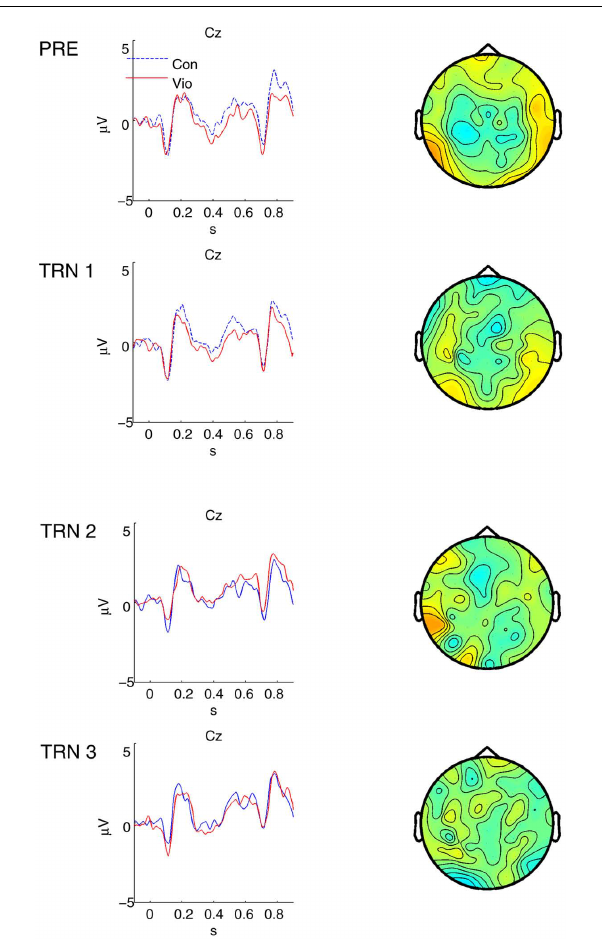
FIGURE 6 |Average event-related potentials for declension violation contrast (3 word). Trace plots indicate average voltage (in μ V) as a function of time at Cz/1; control = Con, violation = Vio.There were no statistically significant clusters.Topographical plots are viewed from the top (left is on the left-hand side).